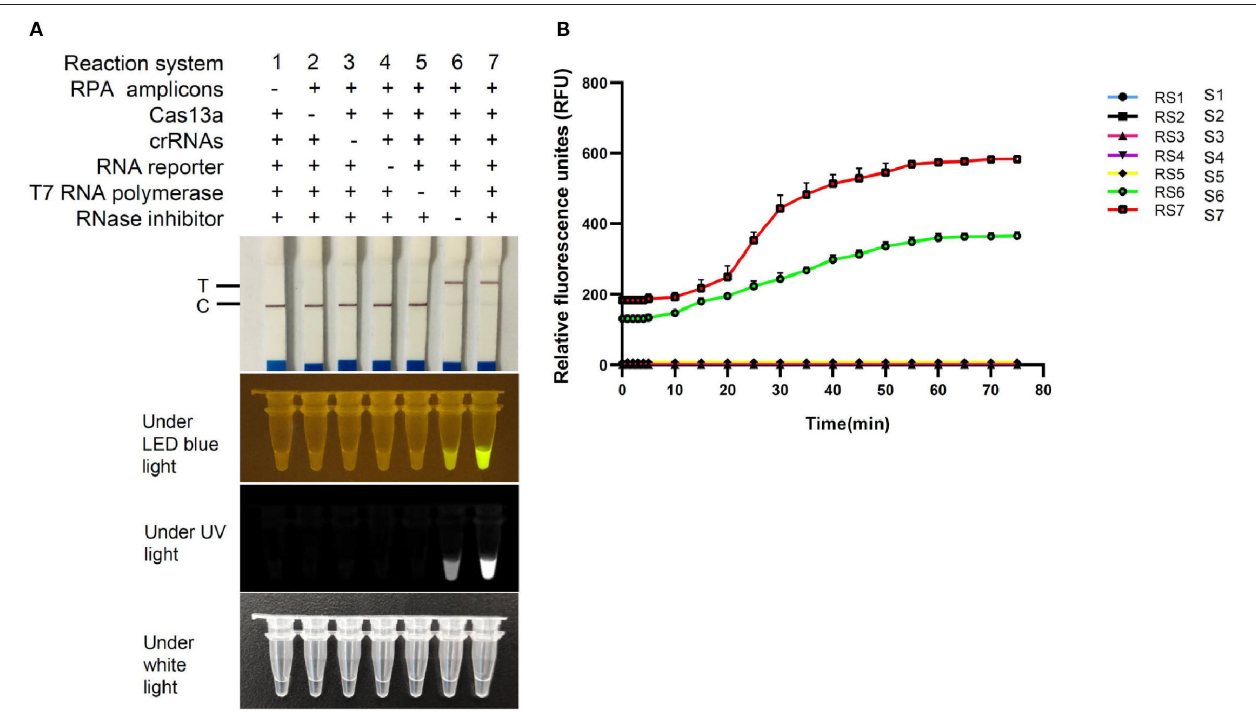
FIGURE 4 | Validation of FCV-Cas13a assays. (A) Detection results of FCV-Cas13a-LFD and FCV-Cas13a-FLOUR. Visual readouts of seven RSs with different components was recorded by endpoint imaging of lateral flow dipstick or fluorescence detector. (B) Fluorescence plottings of seven RSs by FCV-Cas13a-FLUOR. Both RS6 and RS7 were valid, but RS7, by contrast, was more robust. Each experiment was repeated three times.